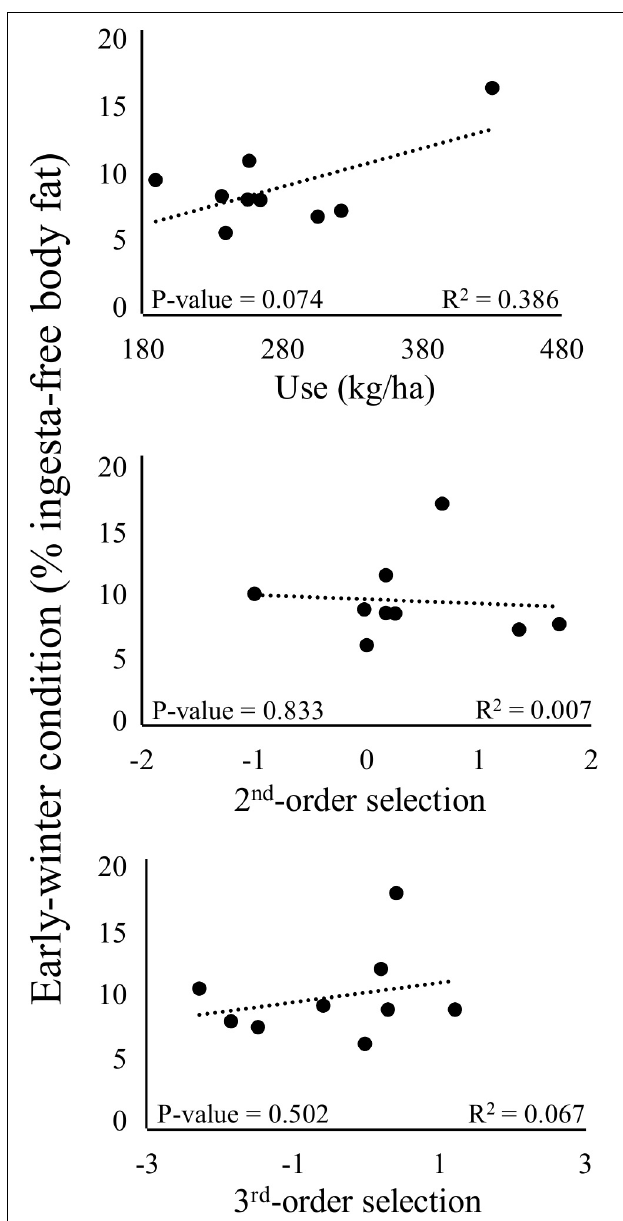
FIGURE 5 | Simple linear regression models of the effects of use (mean predicted biomass of selected and neutral forage plants at all locations used by each individual deer; first panel ), 2nd-order selection (individual-level coefficients from landscape-scale mixed-effects RSFs; second panel ), and 3rd-order selection (individual-level coefficients from home-range scale mixed-effects RSFs; third panel ) of the nutritional landscape on early-winter nutritional condition (% ingesta-free body fat) of female mule deer ( n = 9 animal years) at the Starkey Experimental Forest and Range, Oregon, United